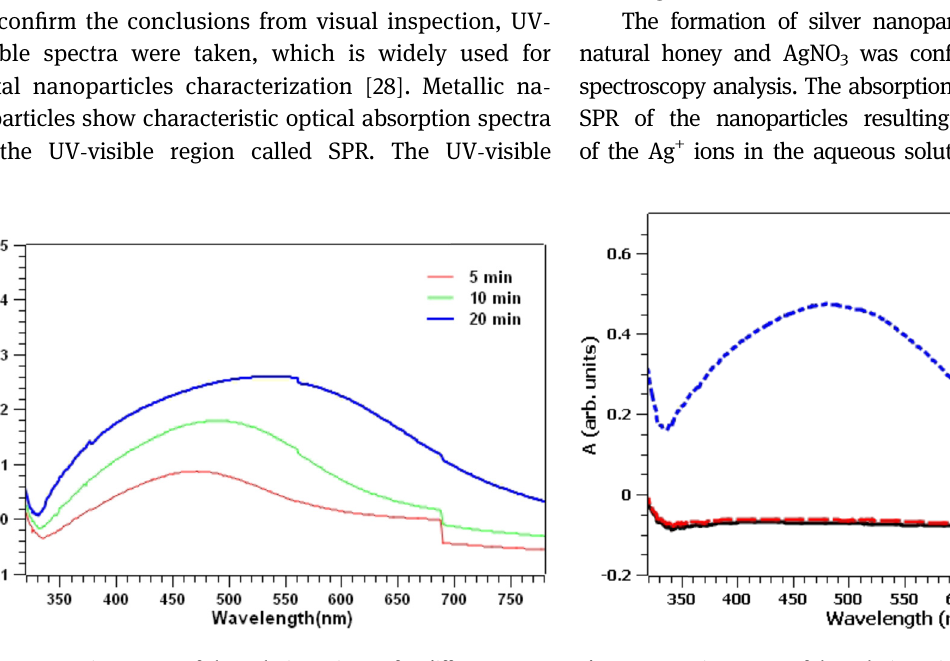
Figure 5: UV - Vis spectra of the solution mixture under di ff erent light